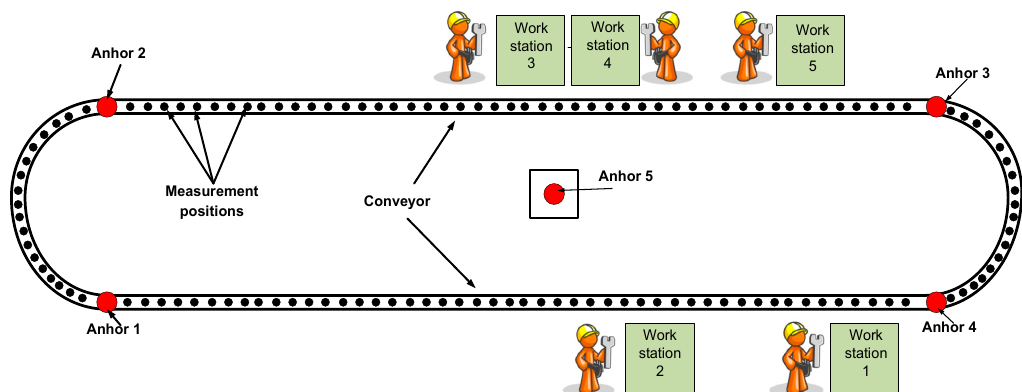
Figure 7. The structure of the measurement position and anchors at the industrial laboratory.